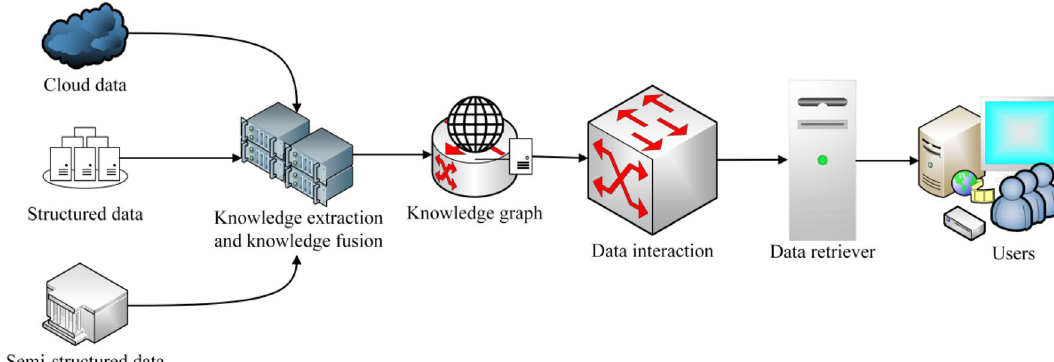
Figure 6. The framework of search engine.